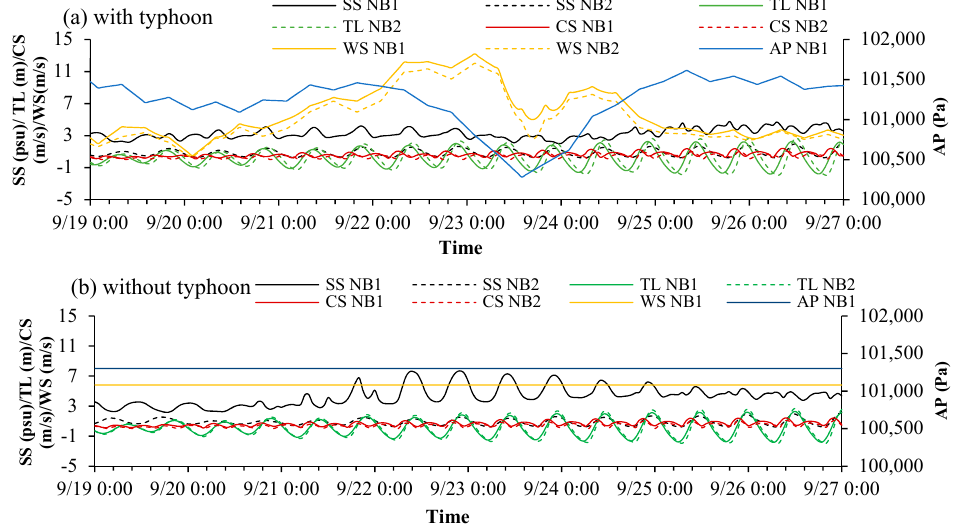
Figure 10. Time history of surface salinity (SS), tidal level (TL), current speed (CS), wind speed (WS) and air pressure (AP) at NB1 and NB2 in 2014: ( a ) with typhoon; ( b ) without typhoon. To obtain the spatial distribution of the tidal level in the YRE, we present the tidal level contours (Figure 11) at 7:00 on 23 September with the strongest storm surge and at 5:00 on 19 September with the same tidal phase during the typhoon rising period. Both have a similar tidal level distribution pattern; however, the tidal level in the YRE is much